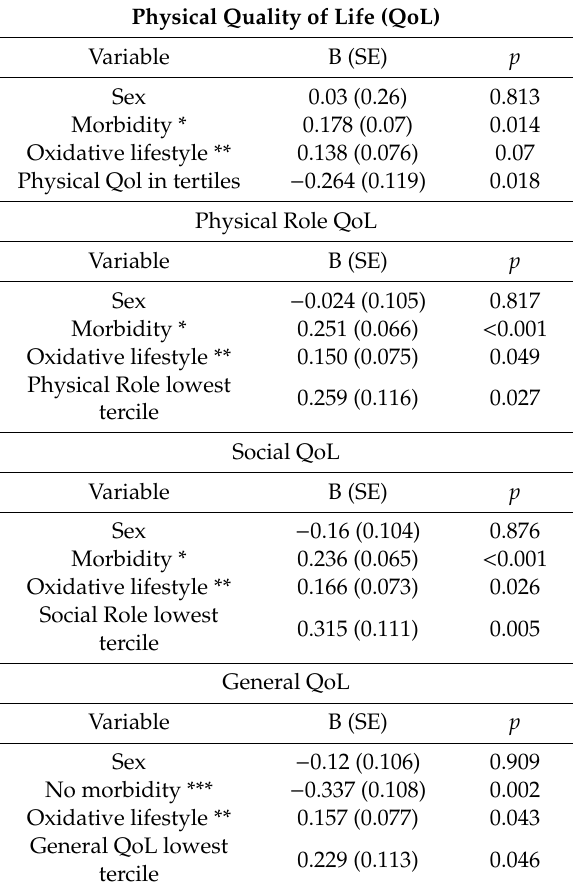
Table 3. Multivariable analysis of FIB-4 adjusted to comorbidity, oxidant lifestyle and quality of